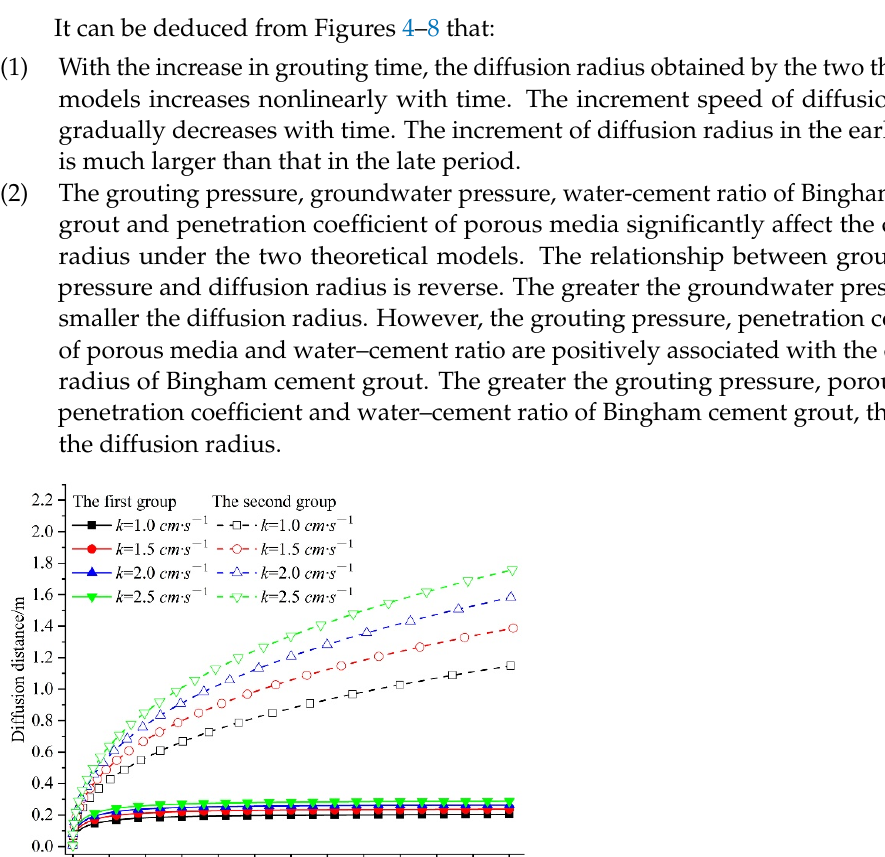
Figure 7. Influence of the water–cement ratio on the diffusion radius of Bingham cement grout.